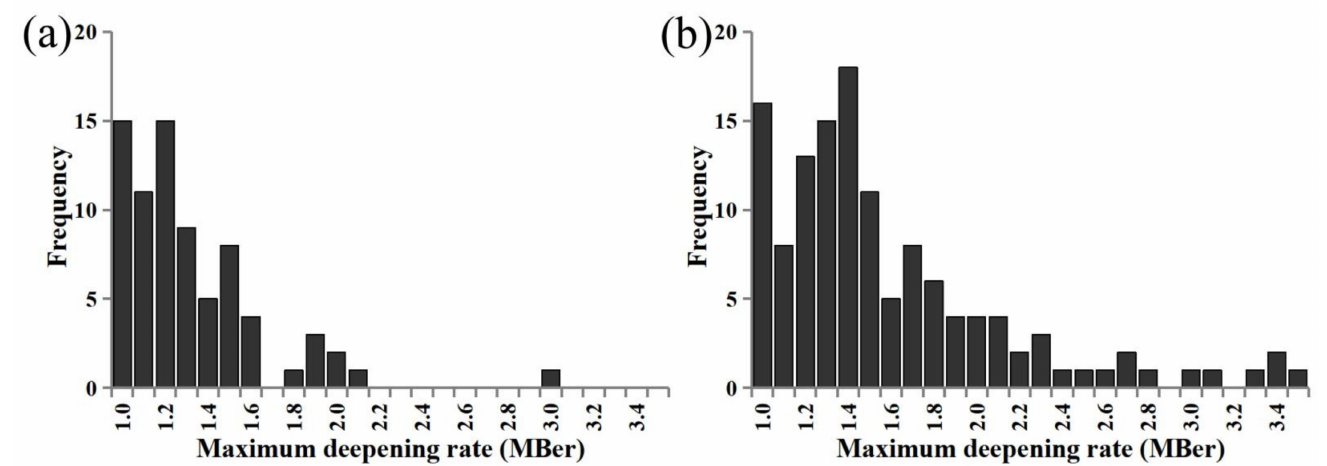
Figure 3. Frequency of the MDR for ECs over ( a ) the Japan Sea and ( b ) Kuroshio/Kuroshio Extension.